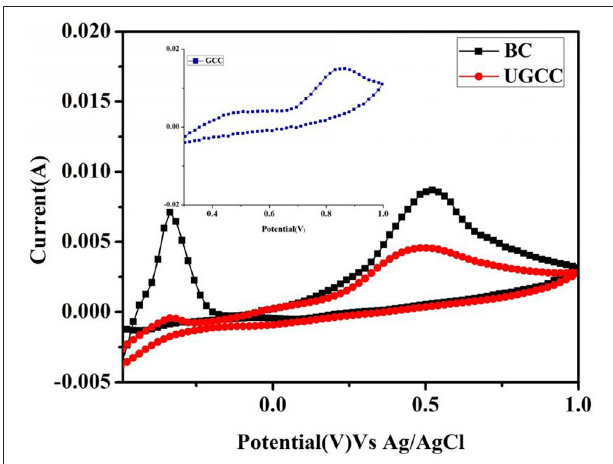
FIGURE 6 | Cyclic voltammograms of BC, UGCC, GCC (inset graph) at 1 T = 60 ◦